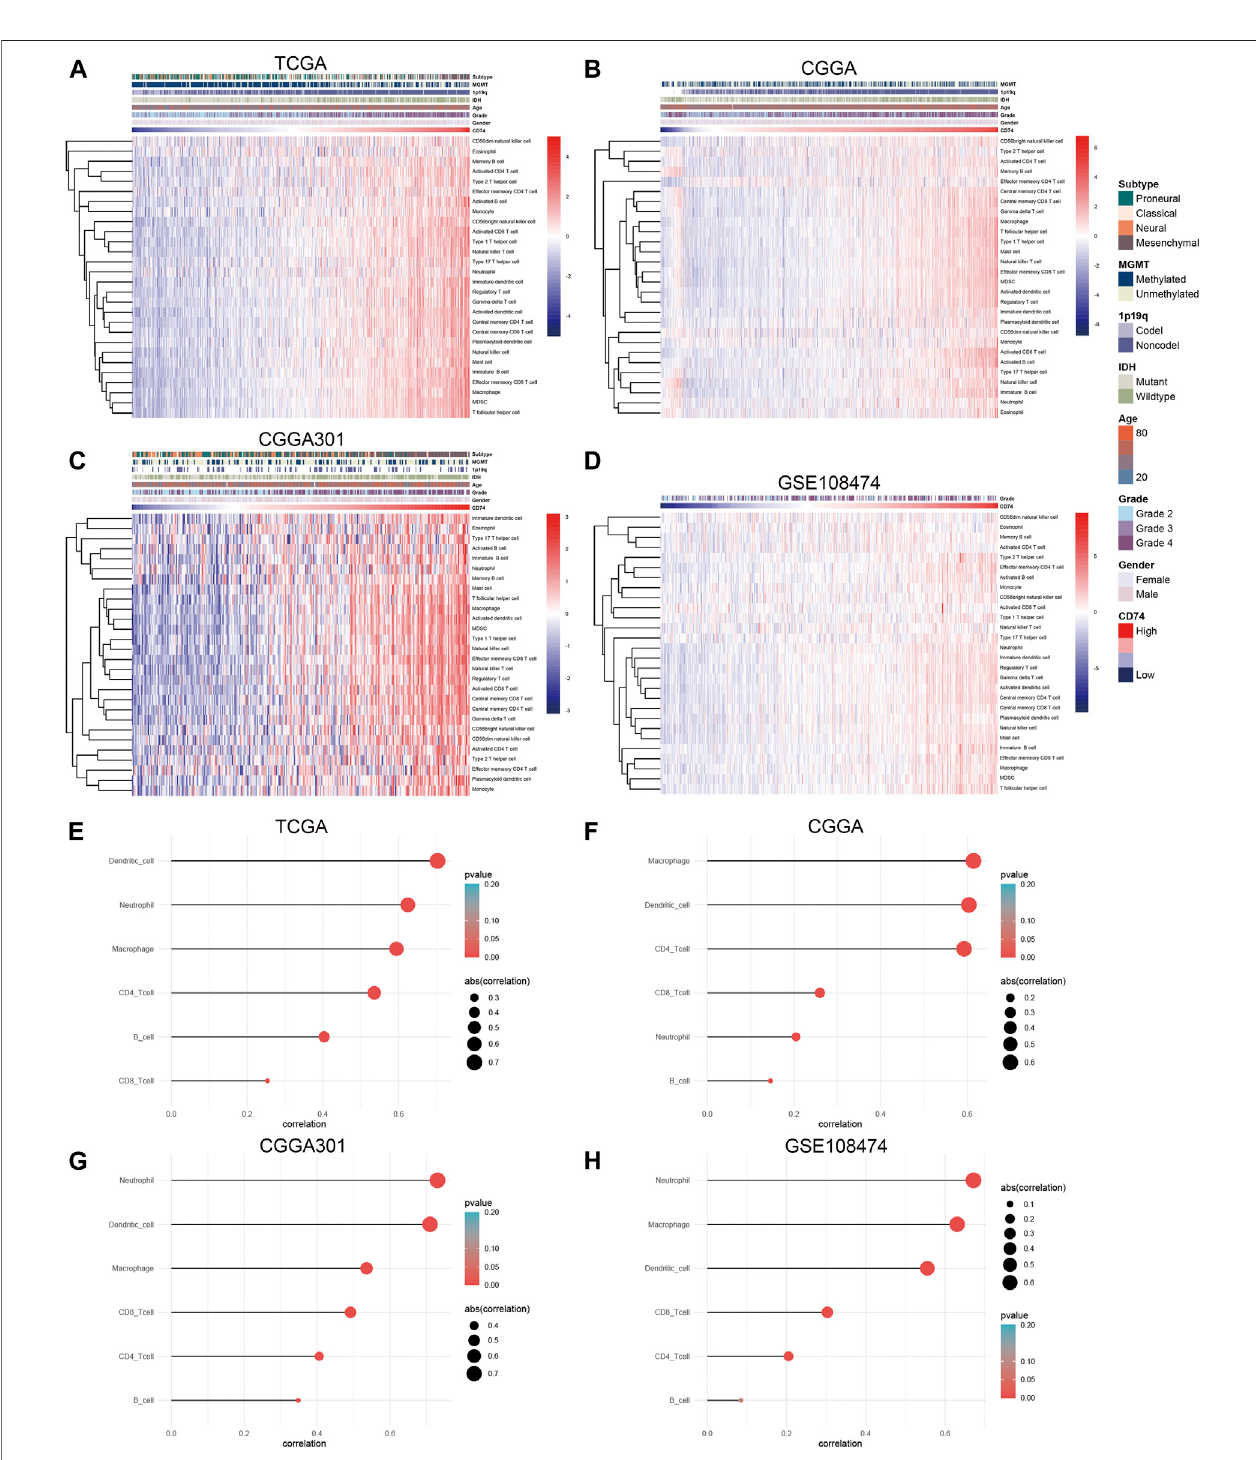
FIGURE 7 | Correlation between CD74 expression and immune in fi ltration. (A – D) The correlation between CD74 expression and immune in fi ltration estimated by the ssGSEA algorithm. (E – H) The correlation between CD74 expression and immune in fi ltration estimated by the TIMER algorithm.